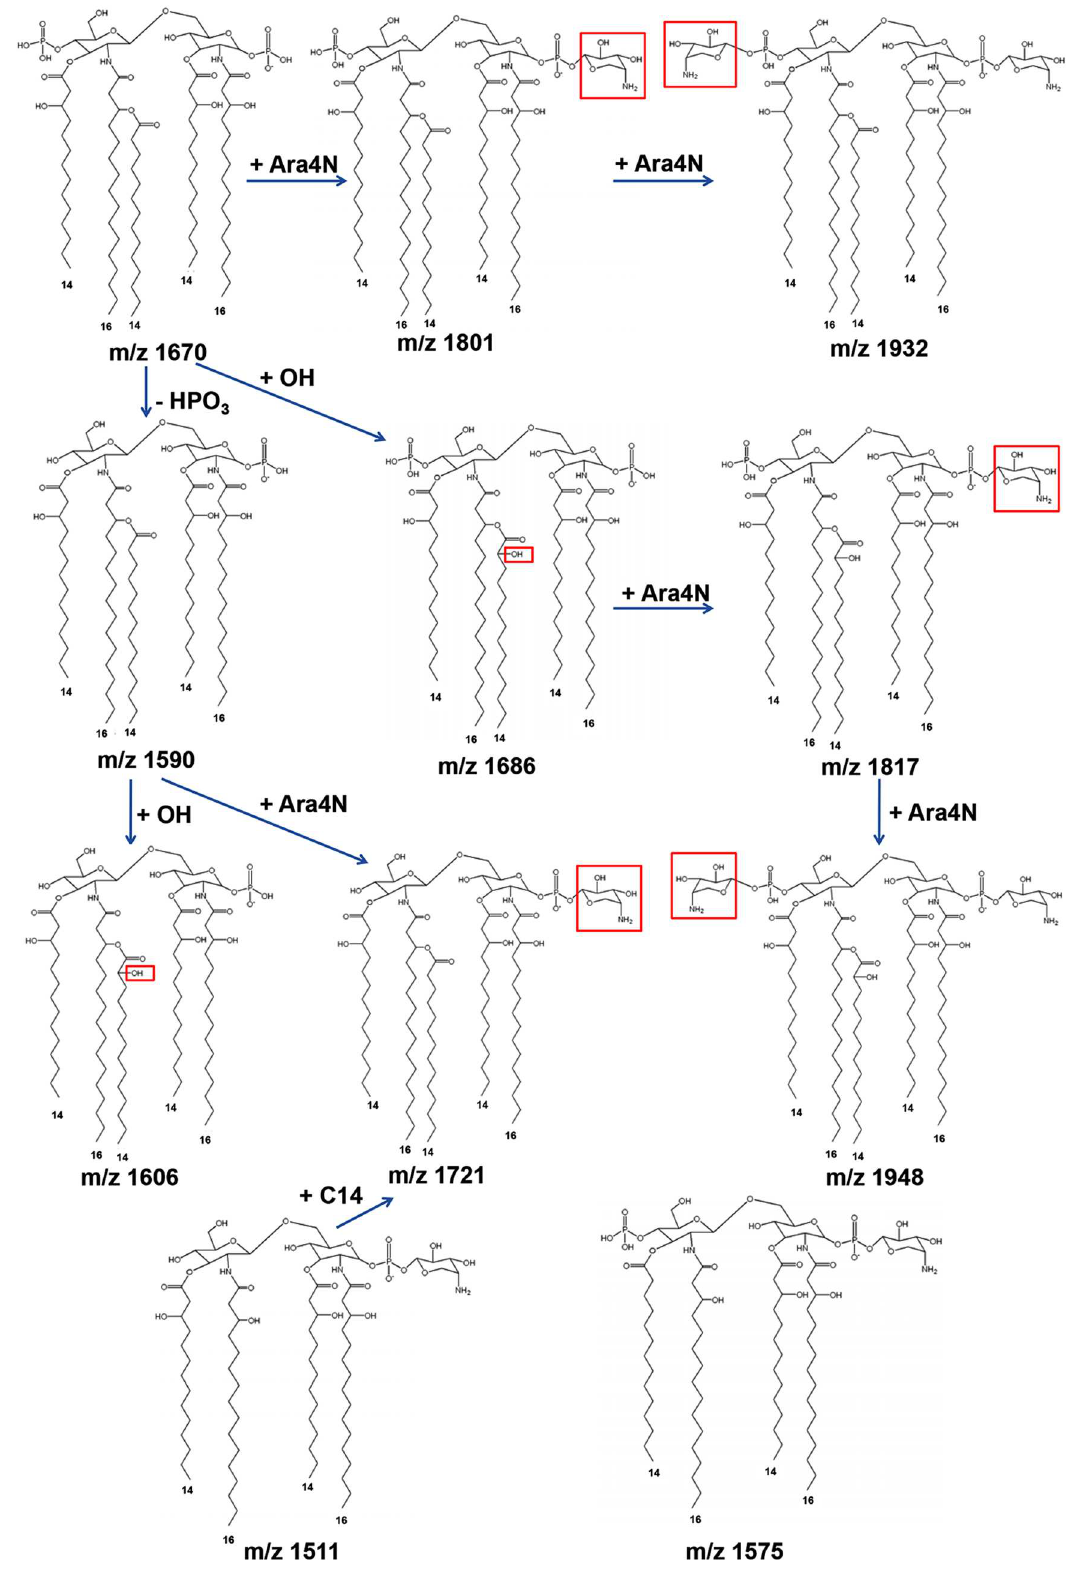
Fig 2. Predicted structure of B . pseudomallei K96243 lipid